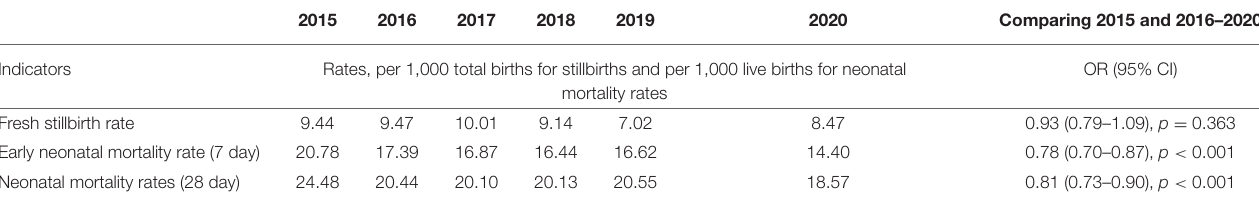
TABLE 2 | Mortality rates and odds ratios comparing before and after implementation of Helping Babies Breathe